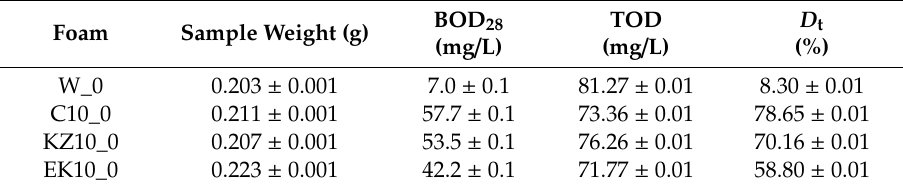
Table 10. Results of biodegradability of analyzed